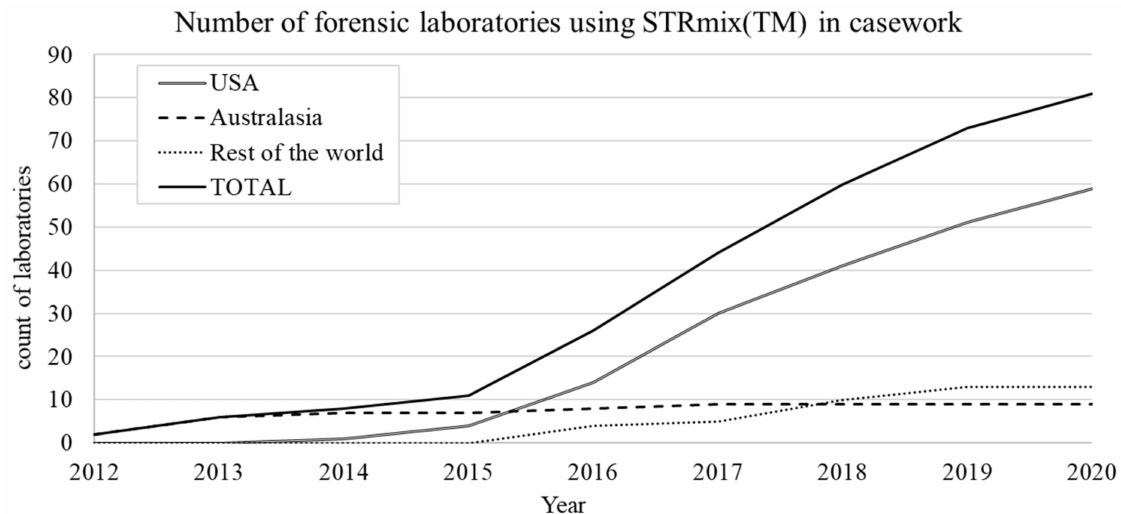
Figure 6. Growth of STRmix ™ use over eight